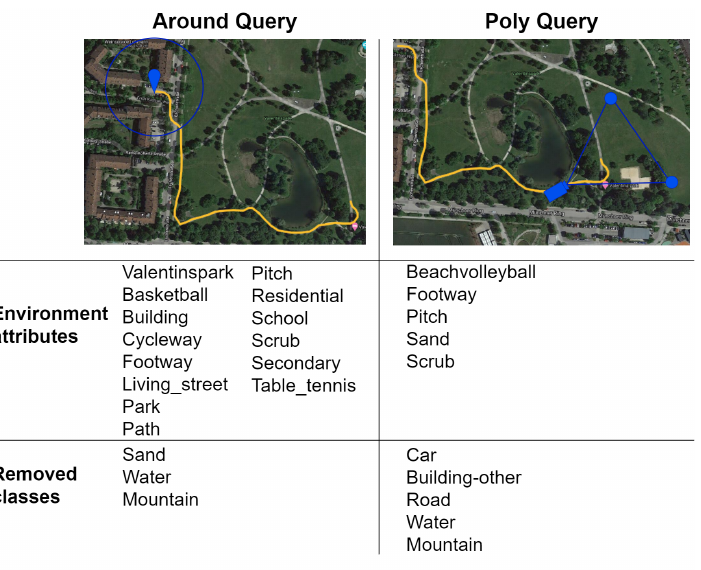
Figure 3. The figure shows the coordinates of two Overpass QL queries (the user path is highlighted in yellow). The left image shows an around query, while the other is a poly query (the camera orientation is shown). The image presents the extracted environment attributes and the corresponding classes that are removed based on those. The attributes are effective in describing the corresponding queried